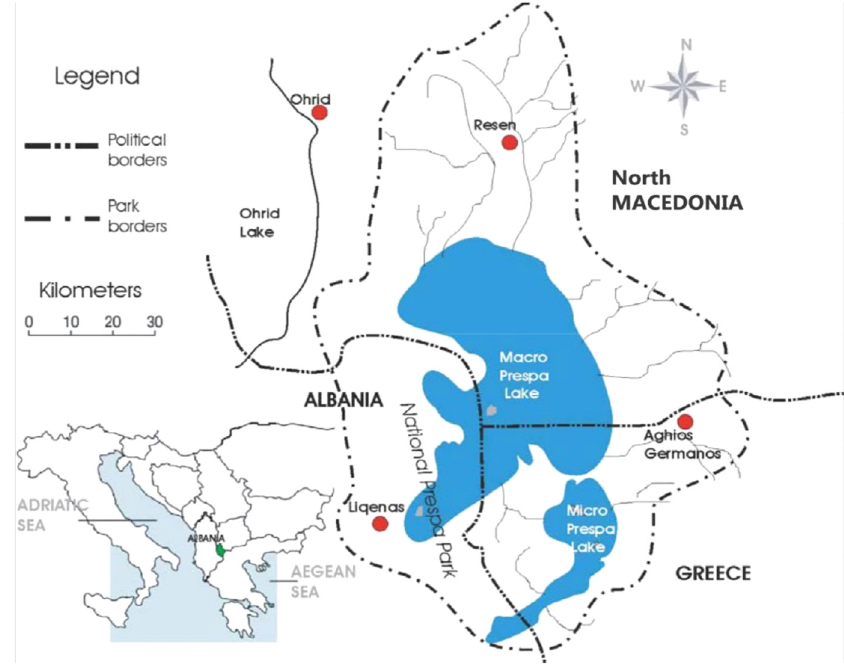
Figure 1. Prespa Lakes watershed.